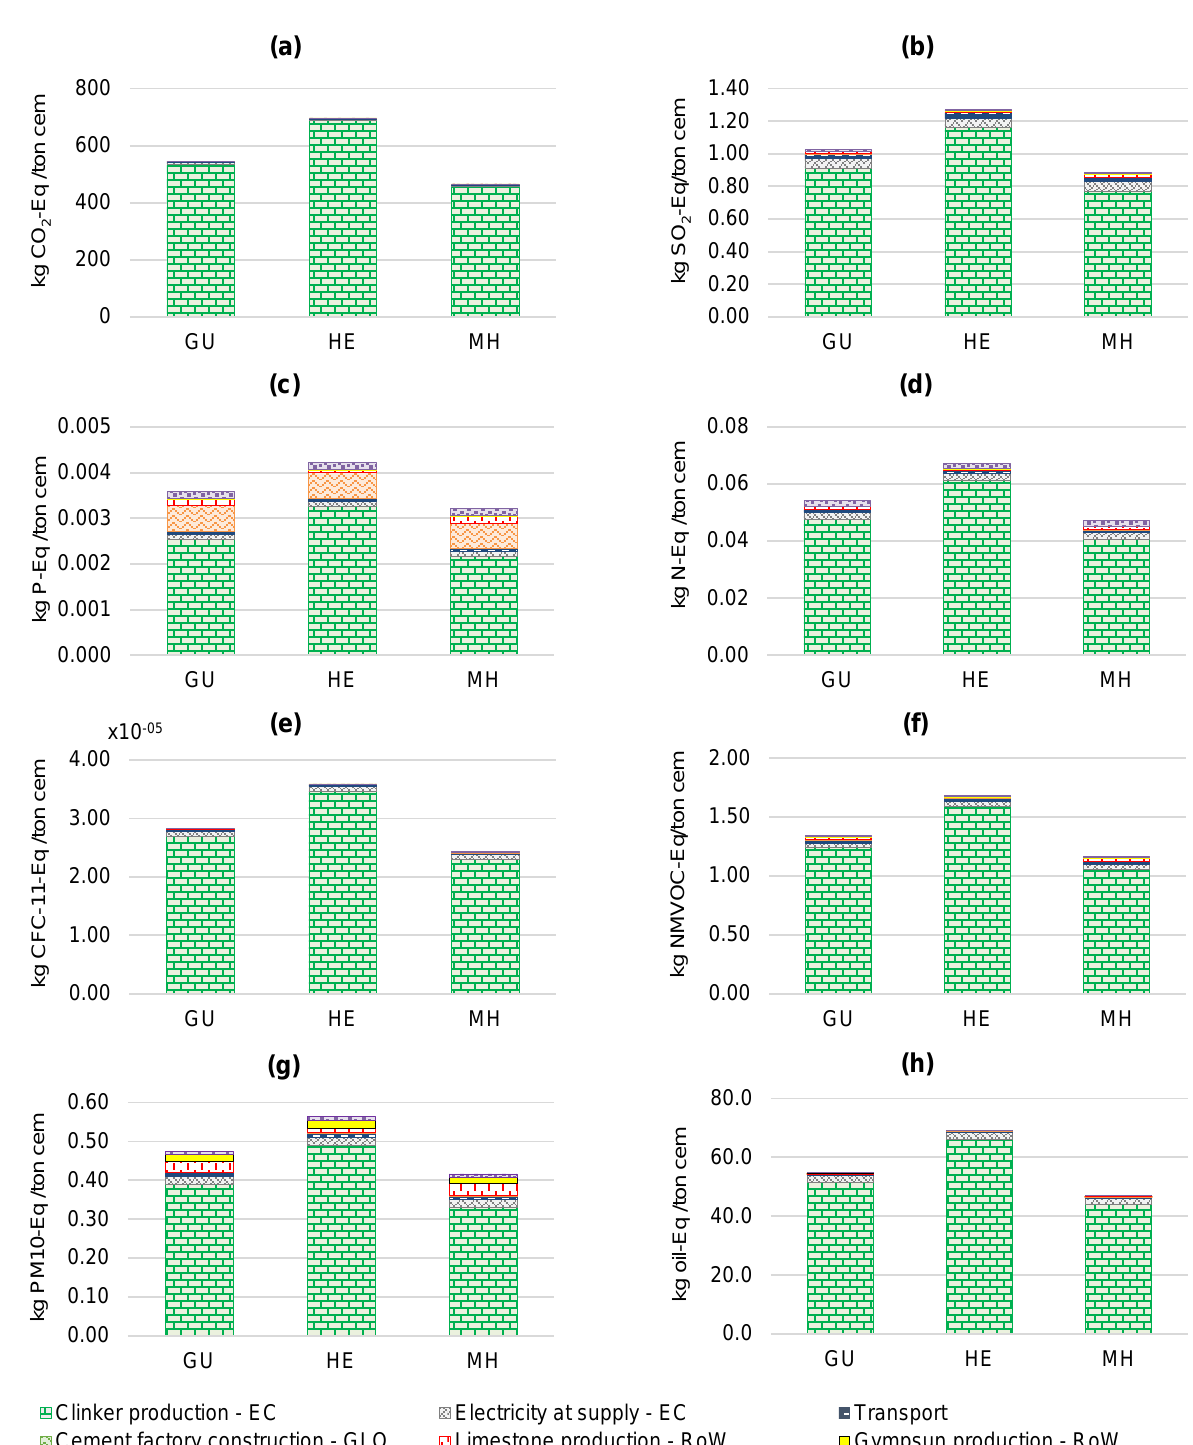
Figure 3. Characterization results for impact categories. The graphs show the impact results per ton of cement (functional unit) by type: GU: General use, HE: High early strength, and MH: Moderate Heat of Hydration, and a contribution analysis for processes. (a) Global warming potential — GWP100; (b) Terrestrial acidification potential — TAP100; (c) Freshwater eutrophication potential — FEP; (d) Marine eutrophication potential — MEP; (e) Ozone depletion potential — ODPinf; (f) Photochemical oxidant formation potential — POFP; (g) Particulate matter formation potential — PMFP; (h) Fossil depletion potential — FDP; EC — Ecuador; GLO — global; and RoW — Rest of world.